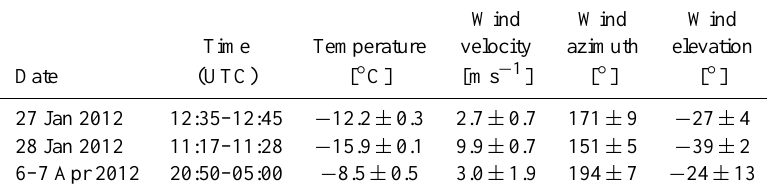
Table 3. Summary of three selected measurement periods at JFJ. Air temperature, wind velocity, wind azimuth direction and wind elevation direction were measured by the sonic anemometer. The wind azimuth angle is the meteorological wind direction (0 ◦ is north; 90 ◦ is east). Wind blowing from below has a negative wind elevation angle. Uncertainties are the standard deviation of the specified